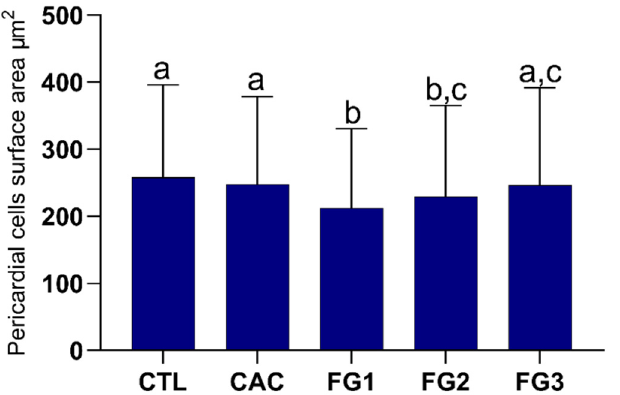
Figure 5. Graph of the surface area of pericardial cells from foragers of Africanized honey bee after five days of oral exposure to different treatments. Letters represent significant differences between the experimental groups by the Kruskal–Wallis nonparametric test, followed by Dunn’s multiple comparisons test ( p < 0.05). Kruskal–Wallis statistic = 43.33. N = 5 individuals per experimental group.